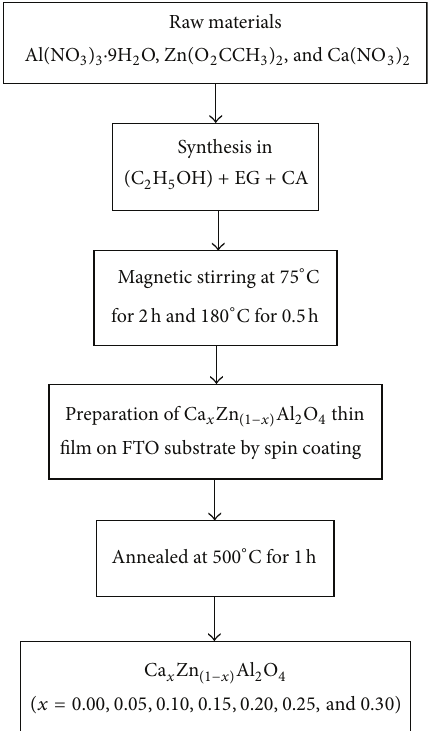
Figure 1: Synthesis of Ca 𝑥 Zn (1−𝑥) Al 2 O 4 thin films based microwave dielectric